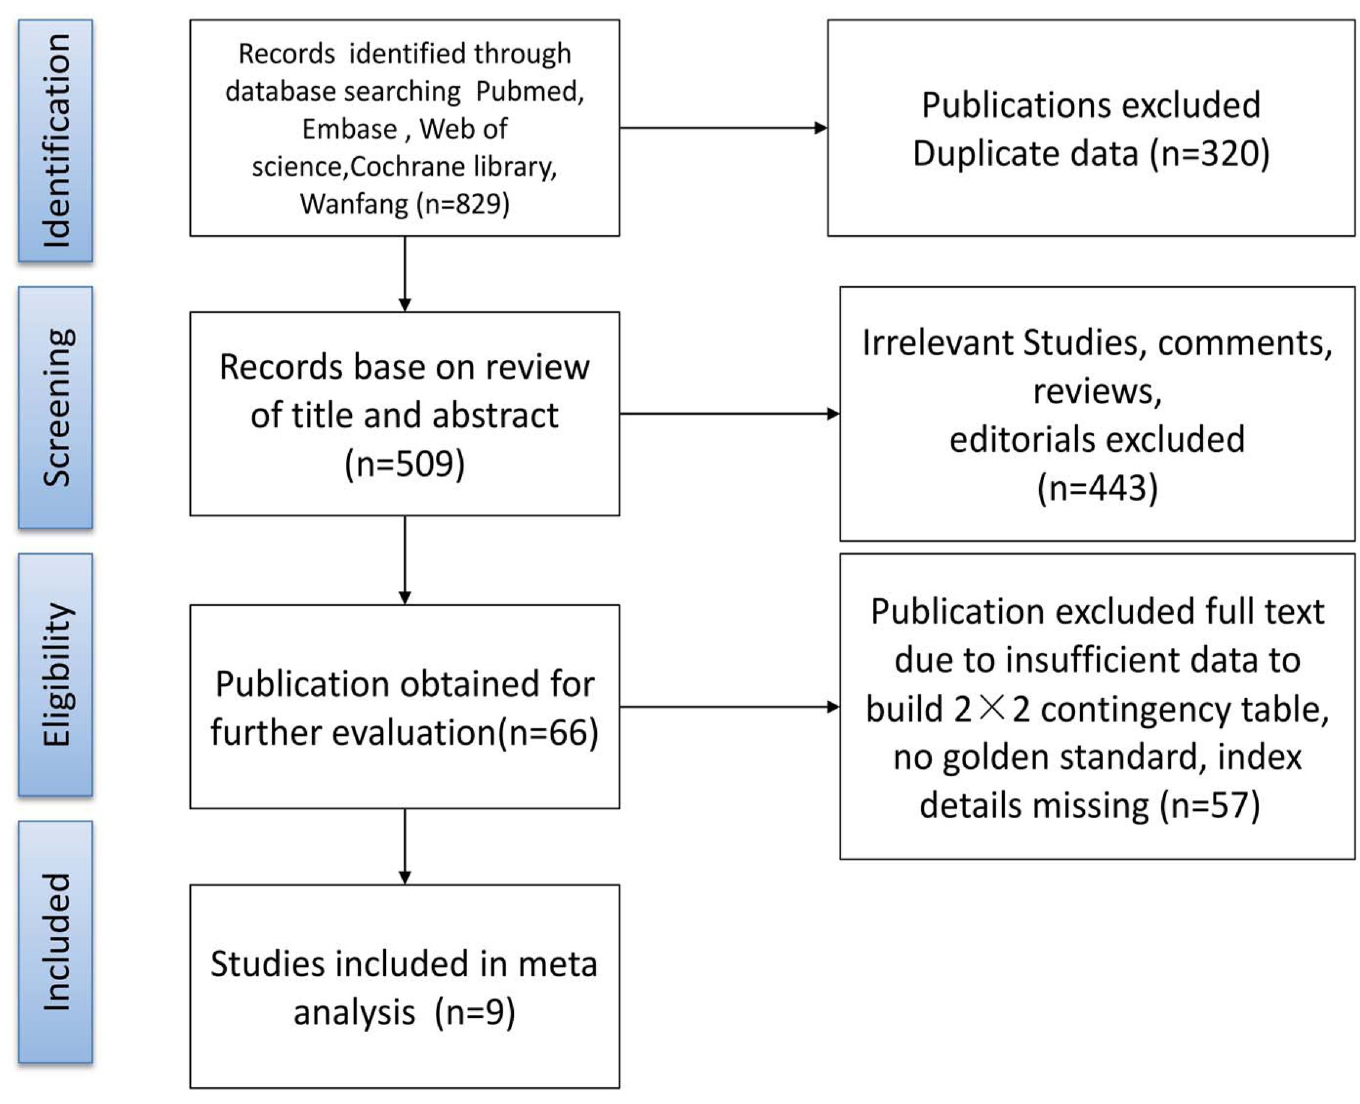
Fig 1. Retrieval flowchart to obtain study data for meta-analysis. https://doi.org/10.1371/journal.pone.0206099.g001 Table 1. Characteristics of the studies included in the